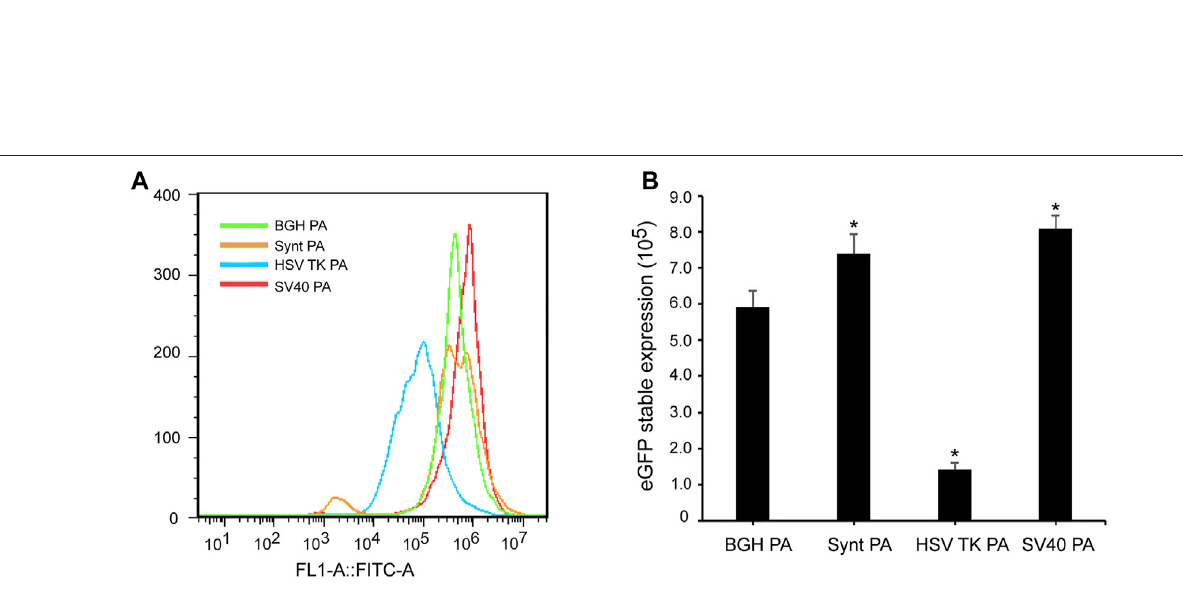
Frontiers in Bioengineering and Biotechnology |